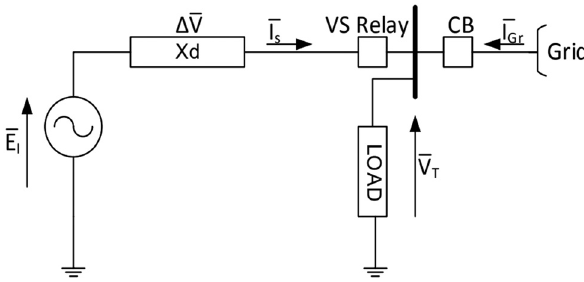
Figure 1: Basic diagram of a single generator connected parallel to the grid [ 19 ] .